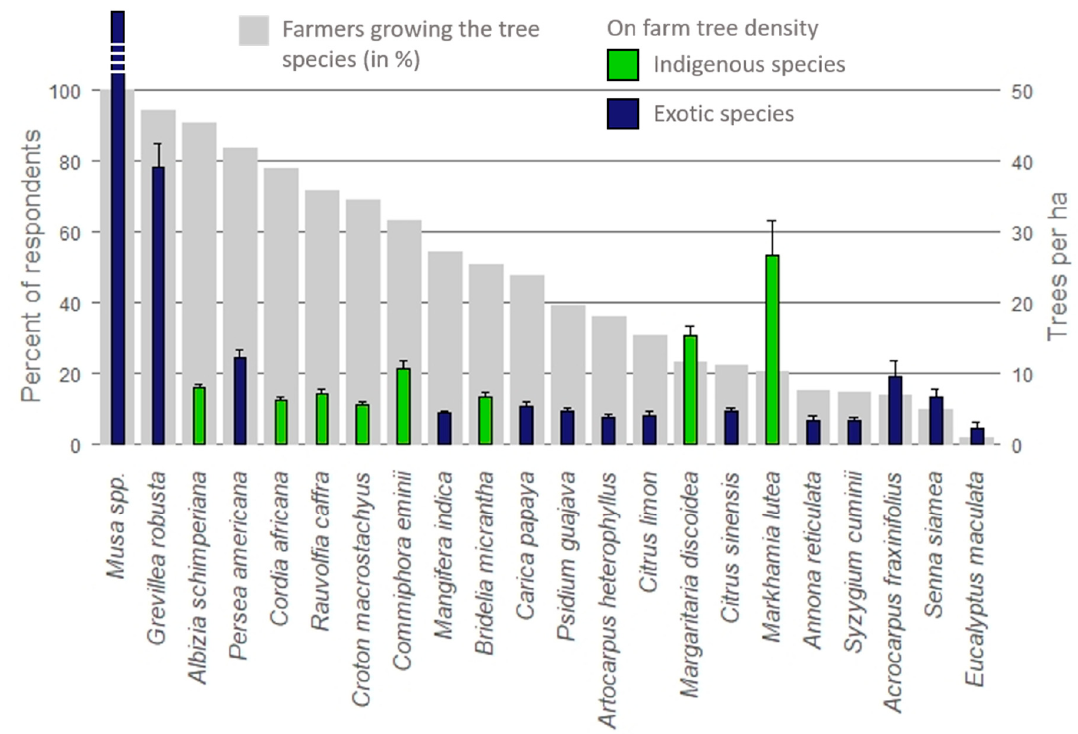
Figure 3. Percent of respondents reporting each species on their farm and average ( + SE) tree density on those farms. The density of Musa spp. is much higher than the scale shown in the graph (1089 trees per ha on average).